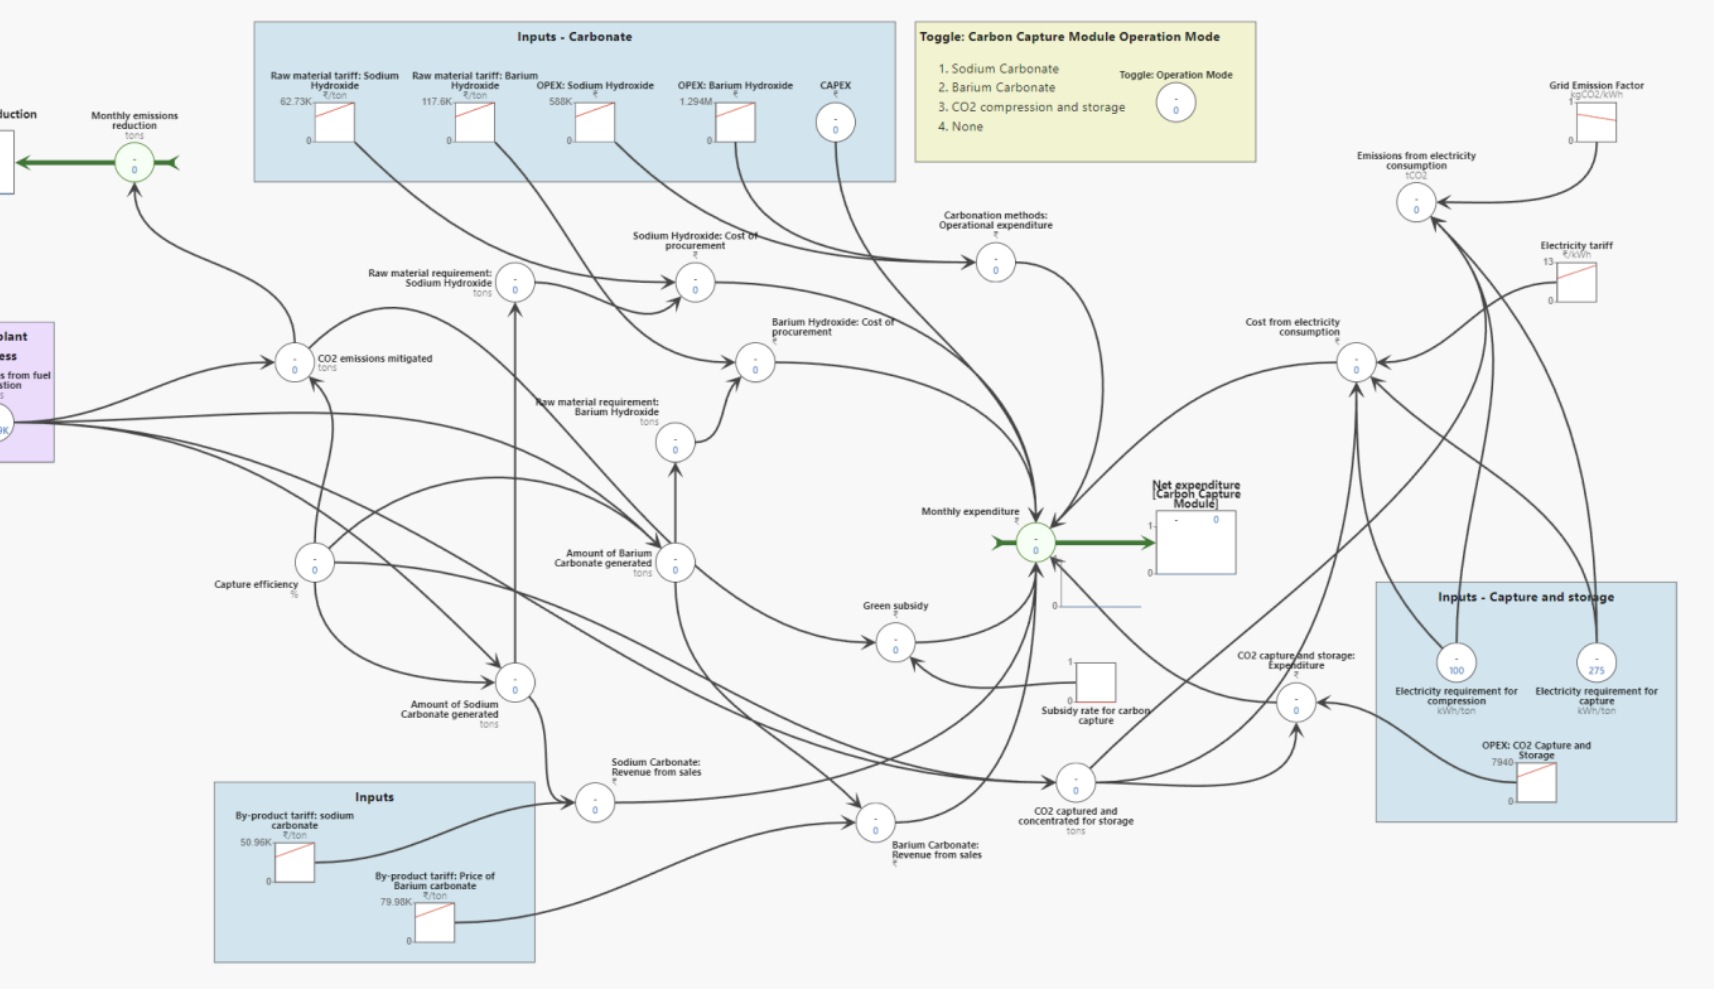
Figure A3. Stock-and-flow diagram of the carbon capture system. Table A4. Description of the variables used in the Carbon Capture Module.